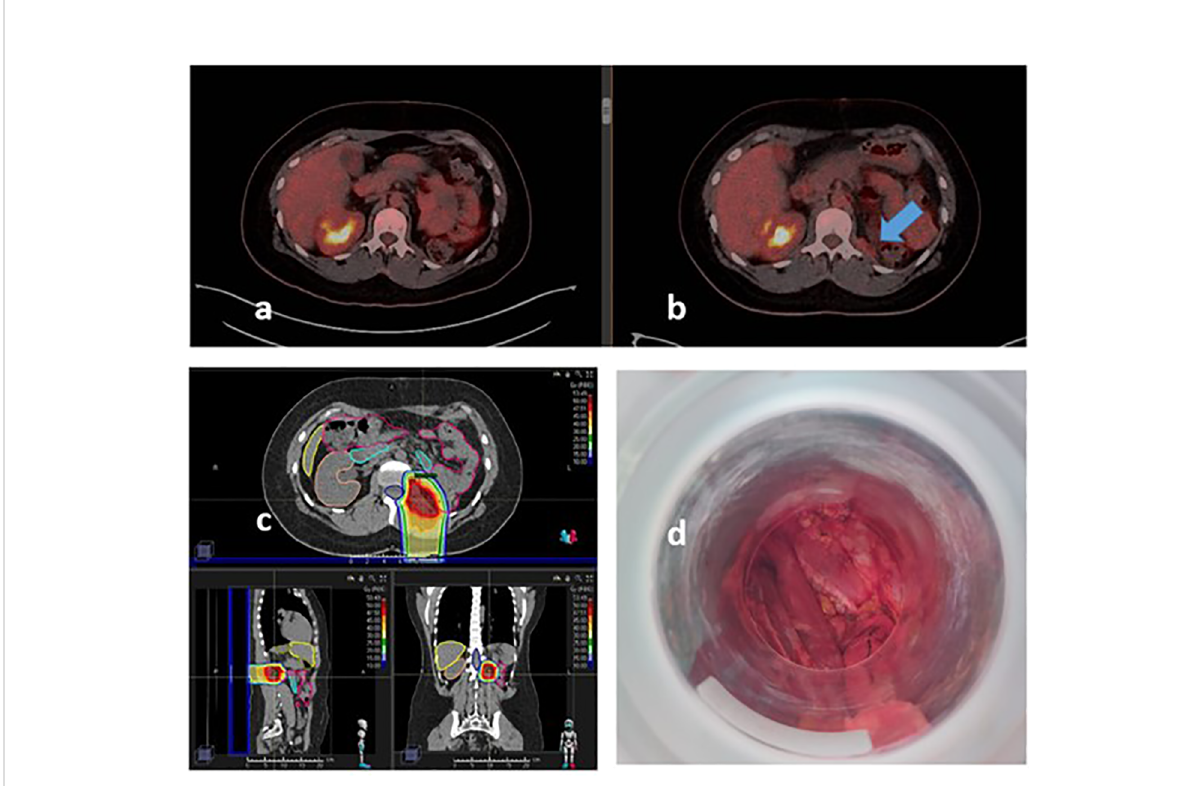
FIGURE 2 Recurrent synovial sarcoma of the lumbar fossae treated with proton therapy and IOeRT. (A) Restaging PET-CT after proton therapy. (B) Pre- proton therapy PET-CT showing metabolic active persistant disease before chemo-radiation in the retroperitoneal left lumbar fossae. (C) Single fi eld proton beam arrangement and dose distribution. (D) Beam ’ s eye view of IOeRT: no mobile sensitive tissues in the target displaced